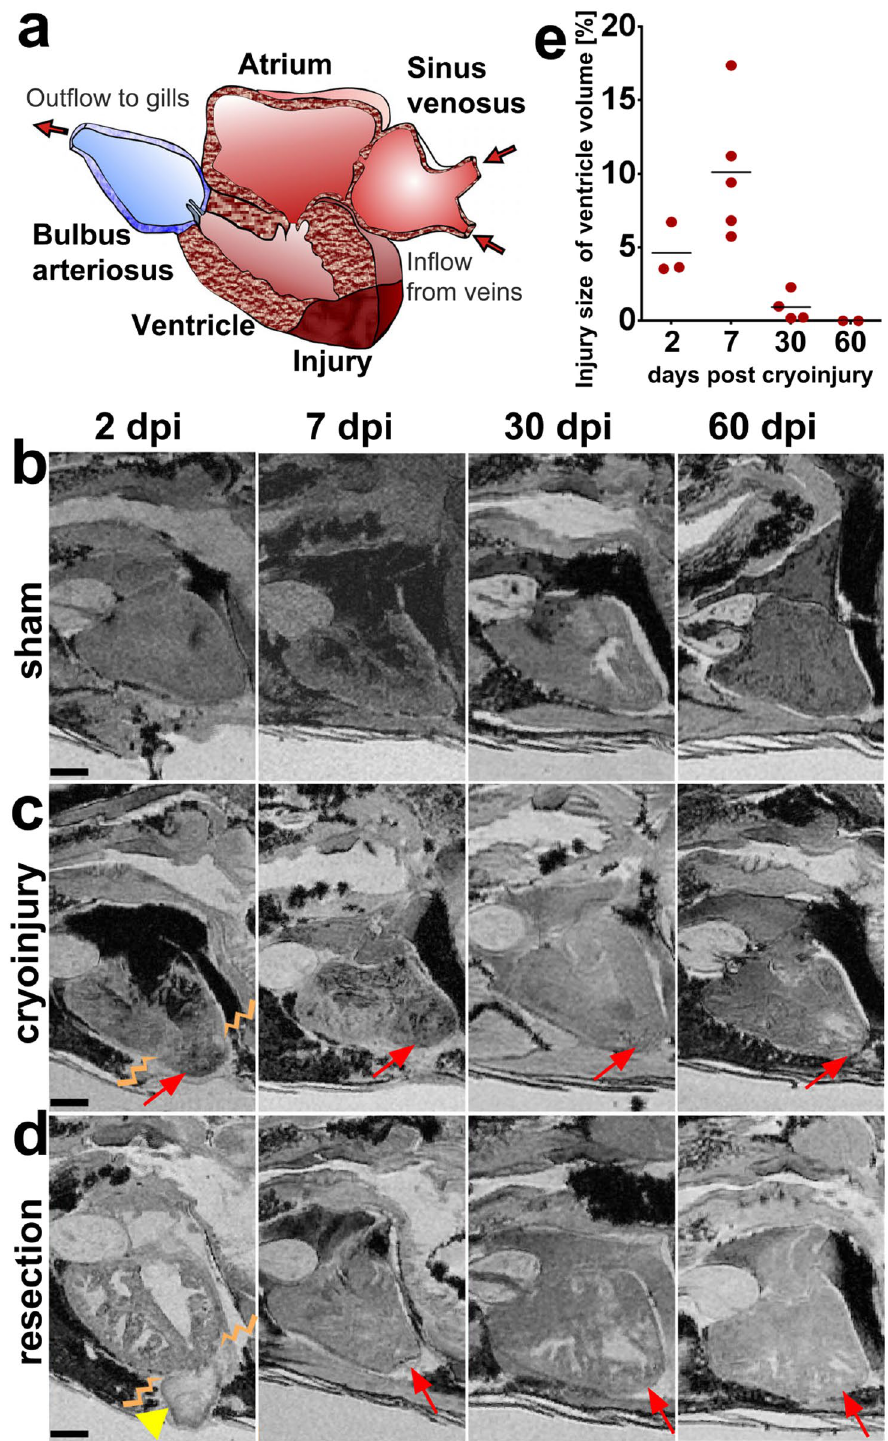
Figure 1. Ex vivo MRI of heart regeneration in different fixed specimens. (a) Schematic drawing of the zebrafish heart in sagittal section view as in the MR images below. The apex of the ventricle is drawn with a cryoinjury to illustrate the location of the lesions. (b–d) Optical sagittal MR sections showing the regeneration process in (b) sham operated controls, (c) cryo-injured, and (d) resected ventricles at 2, 7, 30, and 60 days post injury (dpi) in wt fish. The lesion is indicated with an arrow and the blood clot after resection is indicated with an arrow-head. The border between healthy and damaged heart tissue is indicated by zig-zag lines at 2 dpi. (e) Graph showing the cryoinjury volume in percentage of the ventricular volume at the 4 time points (see c ) investigated for 13 individual fixed specimen [lesion size per ventricle (Y) and the mean value (bar line) at each post injury time point (X)] demonstrating the variability of the lesions between specimen. Anterior to the left, dorsal to the top. n/ time point = 2 per sham group and 4 per injury group. Scale bar 0.5